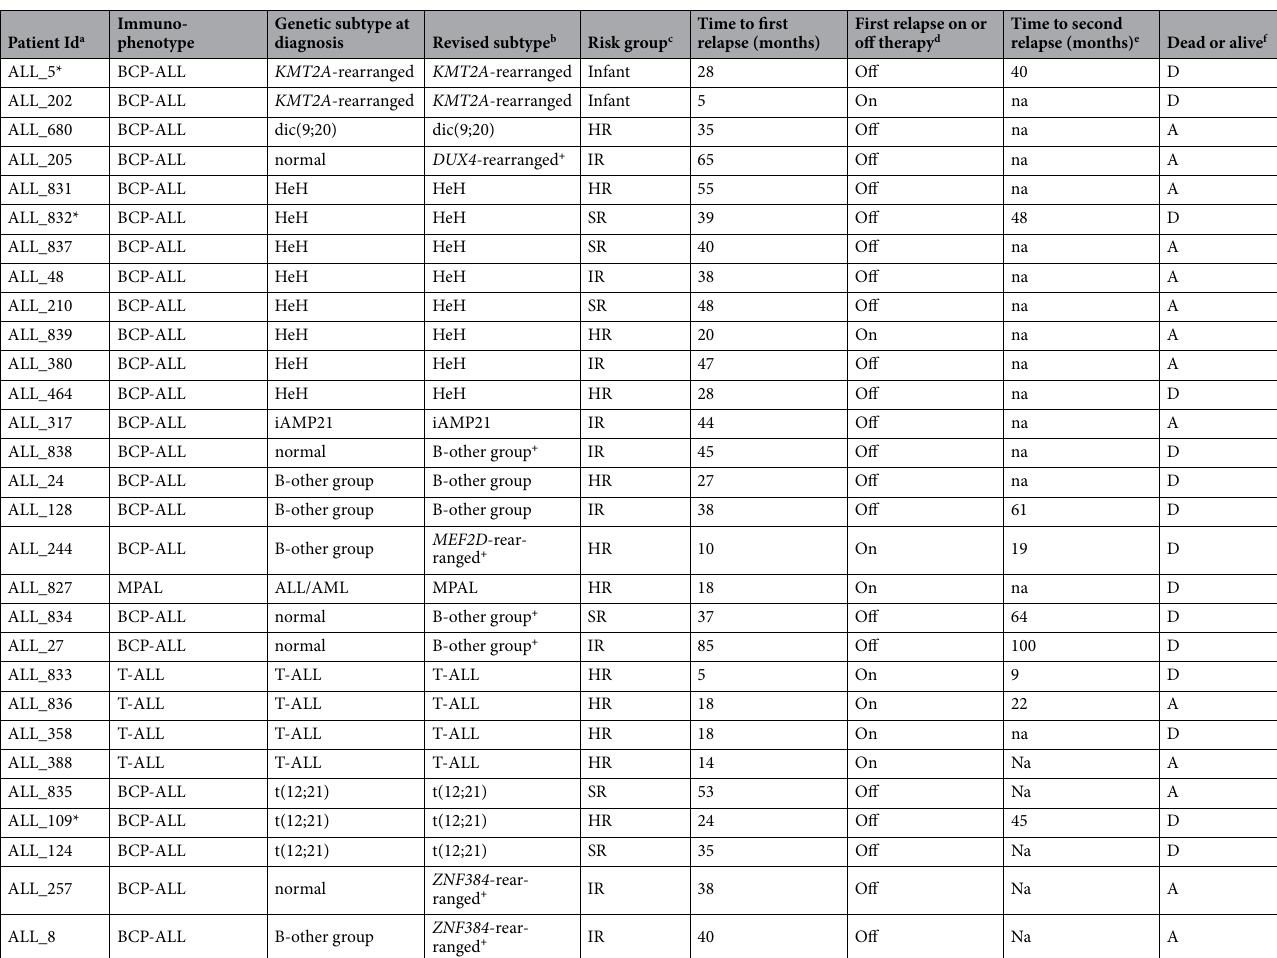
Table 1. Clinical information for 29 patients with acute lymphoblastic leukemia (ALL) included in the study. a Bone marrow transplantated after first relapse "*". b The karyotypes of the ALL samples had been assigned according to the International System for Human Cytogenetic Nomenclature 29 . Revised subtype based on whole genome sequencing data marked with ‘+’; HeH, high hyperdiploidy (51–67 chromosomes); t(12;21),translocation between chromosomes t(12;21)(p13;q22) ETV6-RUNX1 ; iAMP21, intrachromosomal amplification of chromosome 21; dic(9;20), dicentric chromosome (9;20)(p13;q11); ZNF384 -rearranged, translocation between ZNF384 and fusion partner genes; KMT2A -rearranged, translocation between KMT2A and fusion partner genes; DUX4 -rearranged, translocation between DUX4 and fusion partner genes; MEF2D - rearranged, translocation between MEF2D and fusion partner genes; B-other group, unclassified,